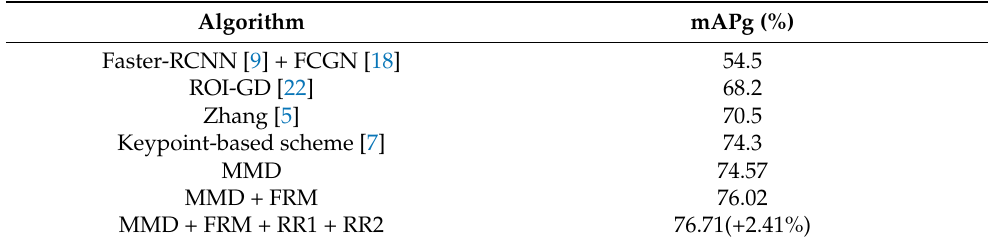
Figure 6. Sample test results of MMD. The three images above are the original images from the VRMD and the following are the results of the test. Table 1. Performance of different algorithm on VMRD